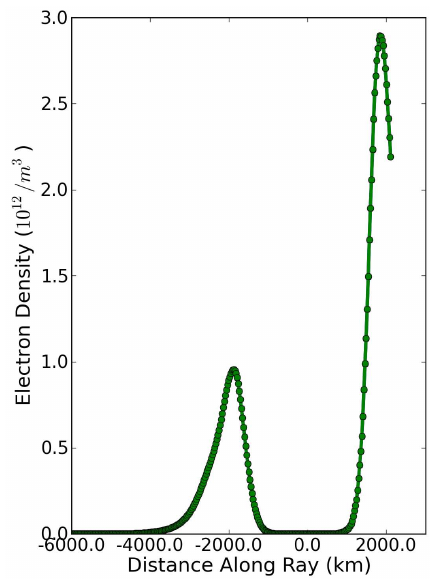
Fig. 6. Electron density versus distance along the ray for the sim- ulated raypath assuming the GAIM electron density distribution (compare to Fig.